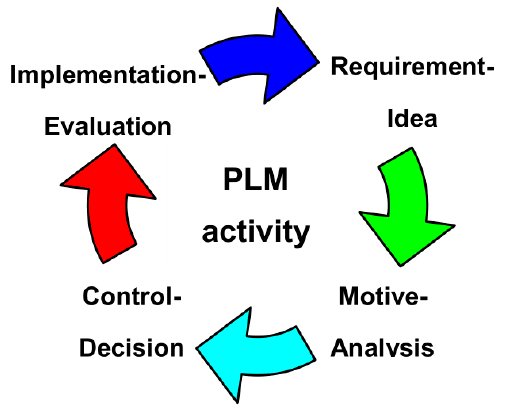
Figure 1. Stages of PLM activity.